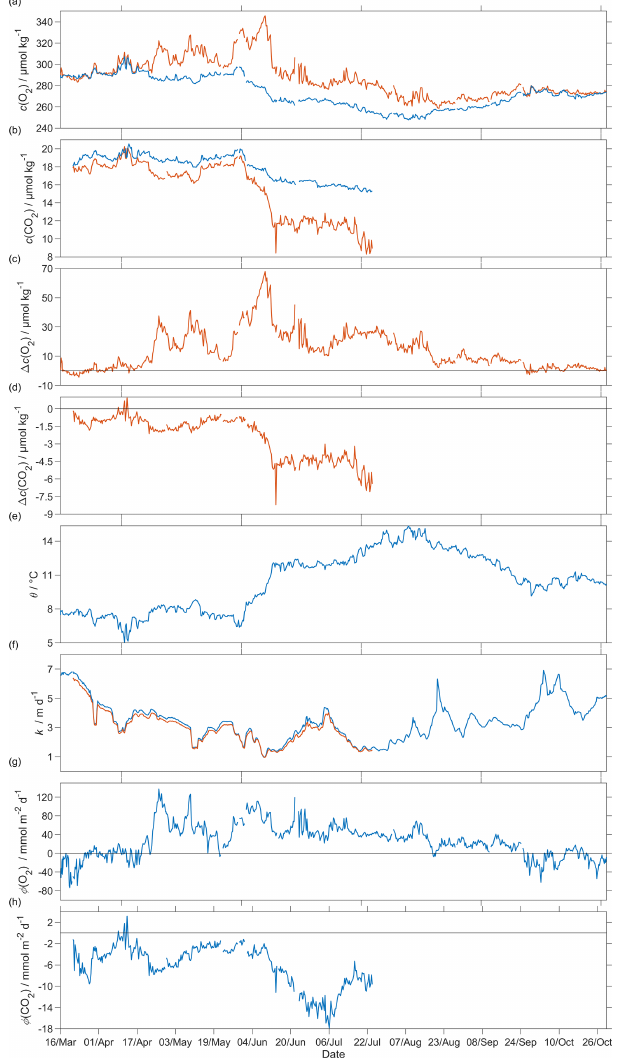
Figure 12. Air–sea flux of O 2 and CO 2 during spring and summer for CO 2 and during spring, summer and autumn for O 2 , (a) c sat (O 2 ) in blue and c (O 2 ) in red, (b) c sat (CO 2 ) in blue and c (CO 2 ) in red, (c) (cid:49)c (O 2 ) = c( O 2 ) − c sat ( O 2 ) , (d) (cid:49)c (CO 2 ) = c( CO 2 ) − c sat ( CO 2 ) , (e) sea surface temperature, (f) k w (O 2 ) in blue and k w (CO 2 ) in red normalised back to 50d (Reuer et al., 2007), (g) oxygen air–sea flux Φ (O 2 ) and (h) CO 2 air–sea flux Φ (CO 2 ). The flux from sea to air is positive, while that from air to sea is